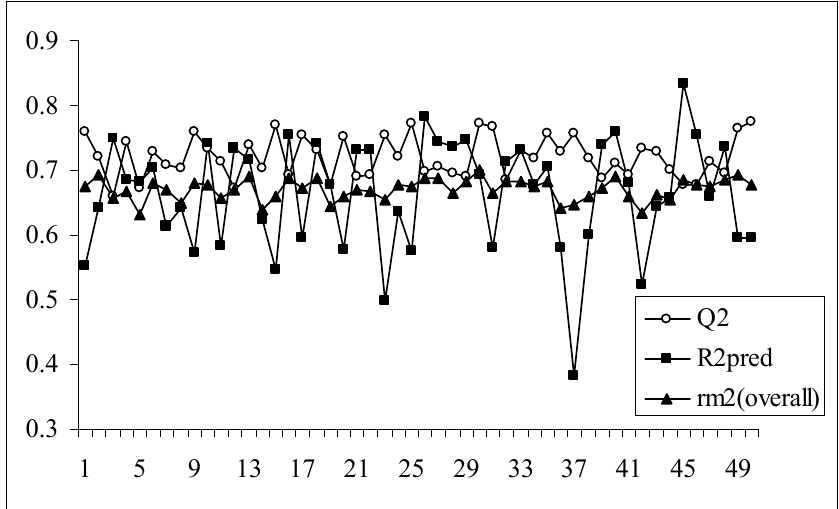
and r m2 values of 50 models (data set (overall) pred